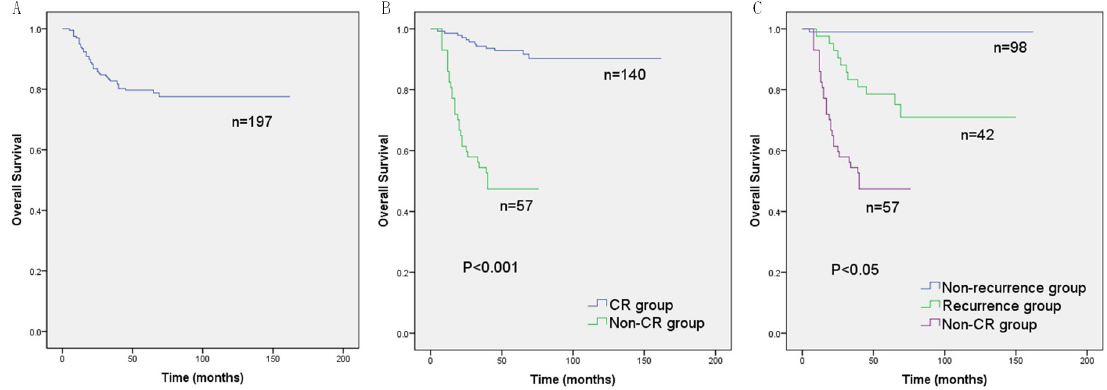
Fig 2. Overall survival (OS) curves of children with hepatoblastoma in each cohort. (A) OS curve of entire cohort in 197 children. (B) Comparison of OS curves between complete remission (CR) group and non-CR group. (C) Comparison of OS curves among non- recurrence group, recurrence group, and non-CR group. (Kaplan-Meier method, P value shown for Log-rank test between variables).